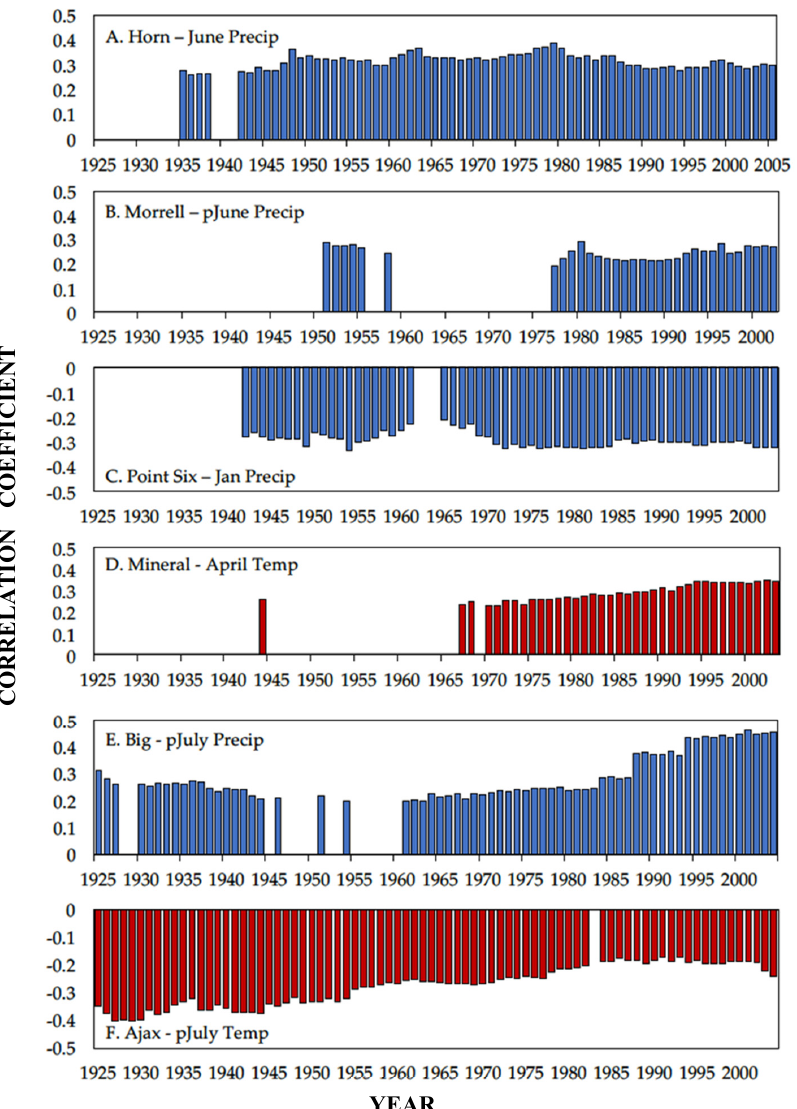
Figure 3. Forward evolutionary interval analysis (1896–2005) between whitebark pine site chronologies and the monthly climate variables exhibiting the strongest correlation coefficients over time ( A – F ). The last years of the forward intervals are listed on the X ‐ axis (30 ‐ year base interval). Significant ( p < 0.05) correlations are blue (precipitation) and red (temperature). Variables preceded by “p” represent months from the previous year.